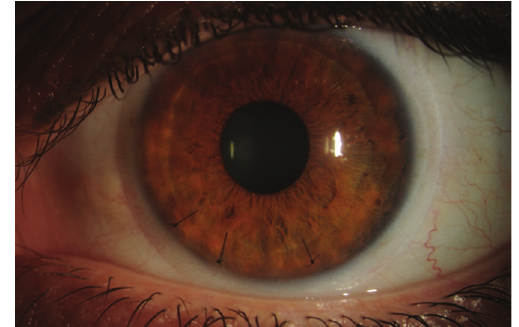
Figure 1: Slit lamp photograph of the injured eye five days after flap dislocation showing several macrostriae approaching the inferior visual axis.